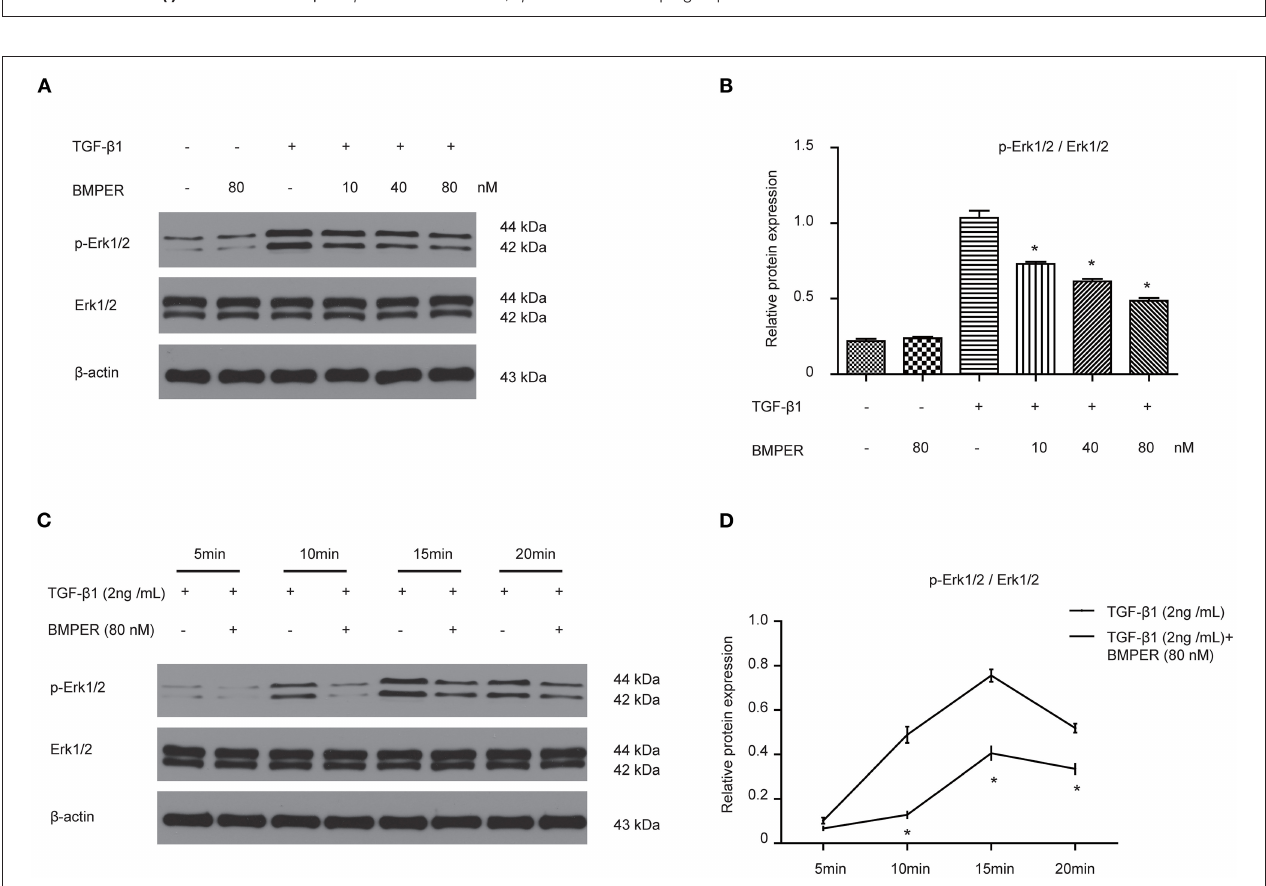
FIGURE 4 | measured by Western blot (B) . The relative protein expression for α -SMA in NRK-49F cells was displayed (C) . The relative mRNA expression for α -SMA in NRK-49F cells was shown (D) . Collangen I was measured by Western blot (E) and the relative protein expression for collangen I (F) . Values are the means ± SEM ( n = 3). Representative photographs for α -SMA in NRK-49F cells after various treatments were displayed by immunofluorescence staining (G) . Graphic presentation of mean fluorescent intensity in various groups (H) . Neither treatment modalities significantly affected NRK-49F counts. Cell numbers were counted after various treatments for 48h (I) . Scale bar = 100 µ m. * p < 0.05 vs. control; † p < 0.05 vs. TGF- β 1 group.